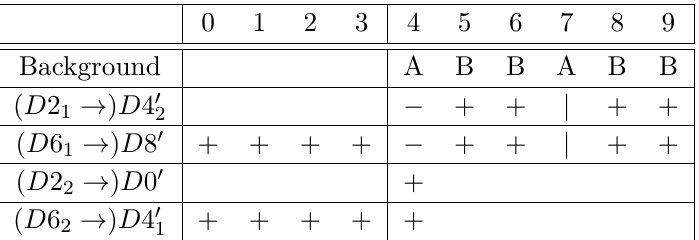
Table 4 . Brane configuration after the T-duality. A and B denote angles and B-field. For instance, D4’ and D8’ branes extend over a line in 47 2